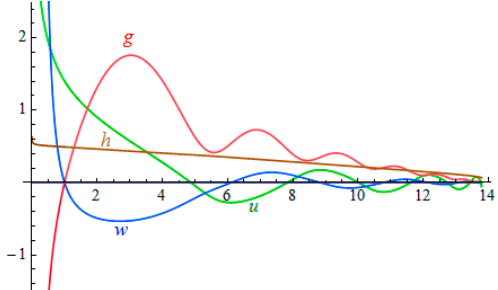
Figure 2. An example of a regular solution to the set of Equations (24)–(27) with boundary conditions in Equation (33). x g = 1, u g = 2 − 0.01. In accordance with Equation (31), h g = 0.492853. The horizon radius x h = 13.78581985 is found numerically.